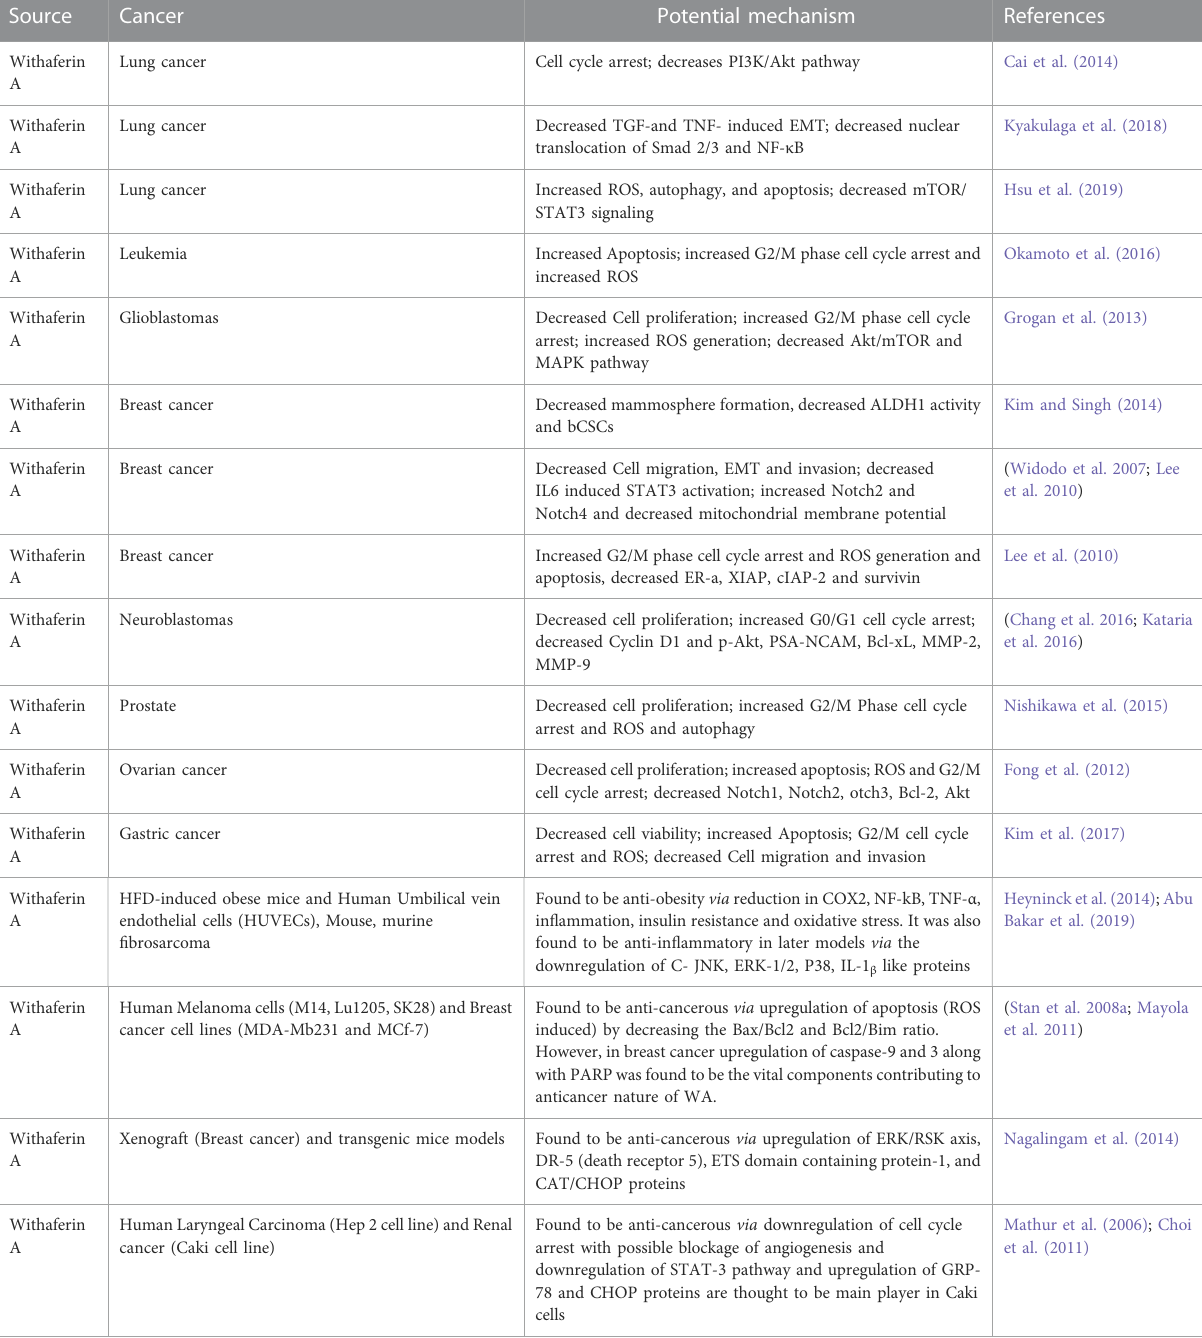
TABLE 1 Preclinical status of Withaferin A in